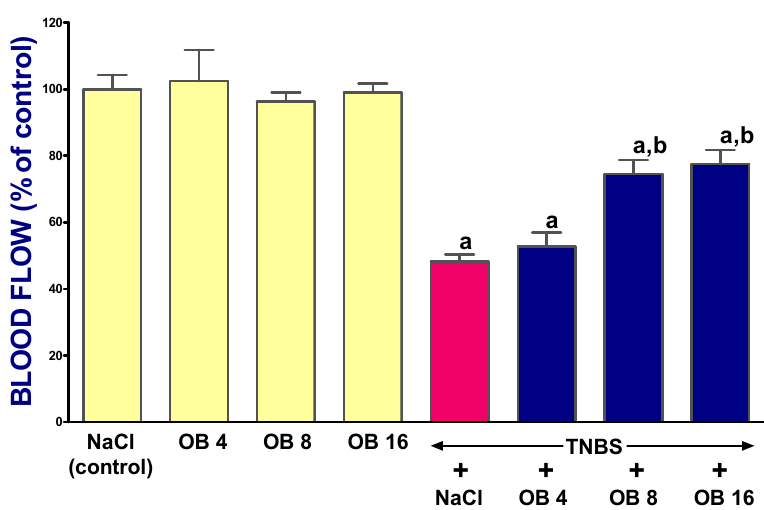
Figure 3. Effect of saline (NaCl) or obestatin given at doses of 4 nmol/kg (OB4), 8 nmol/kg (OB8), or 16 nmol/kg (OB16), and induction of TNBS-induced colitis on mucosal blood flow in the colon. Mean ± SEM. n = 10 in each group of animals. a p < 0.05 when compared with control; b p < 0.05 when compared with colitis + NaCl.